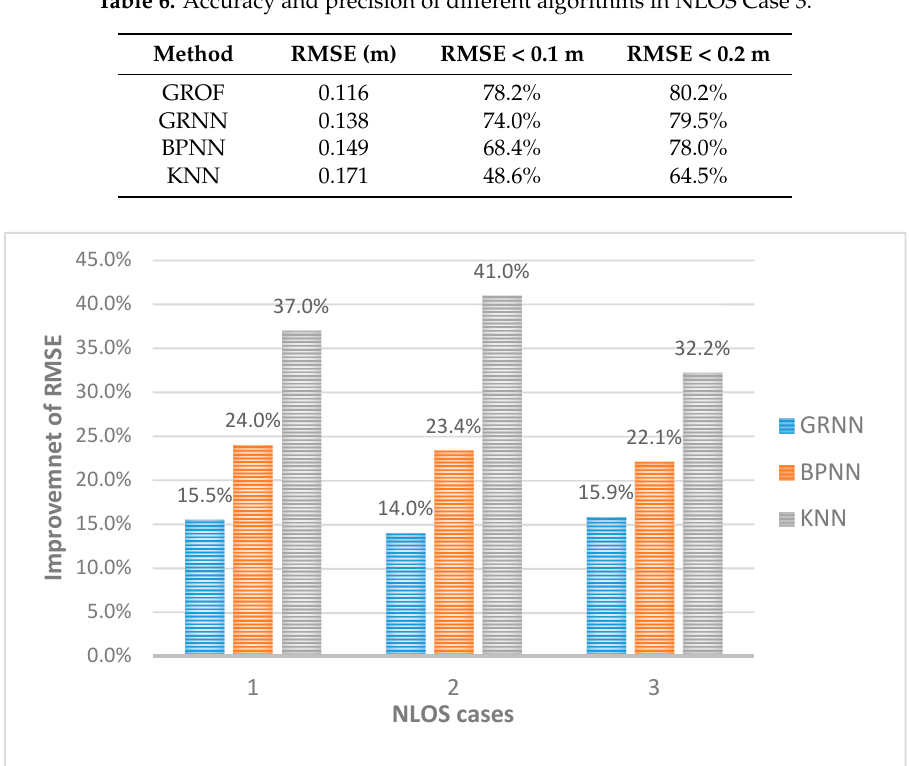
Table 6. Accuracy and precision of different algorithms in NLOS Case 3.